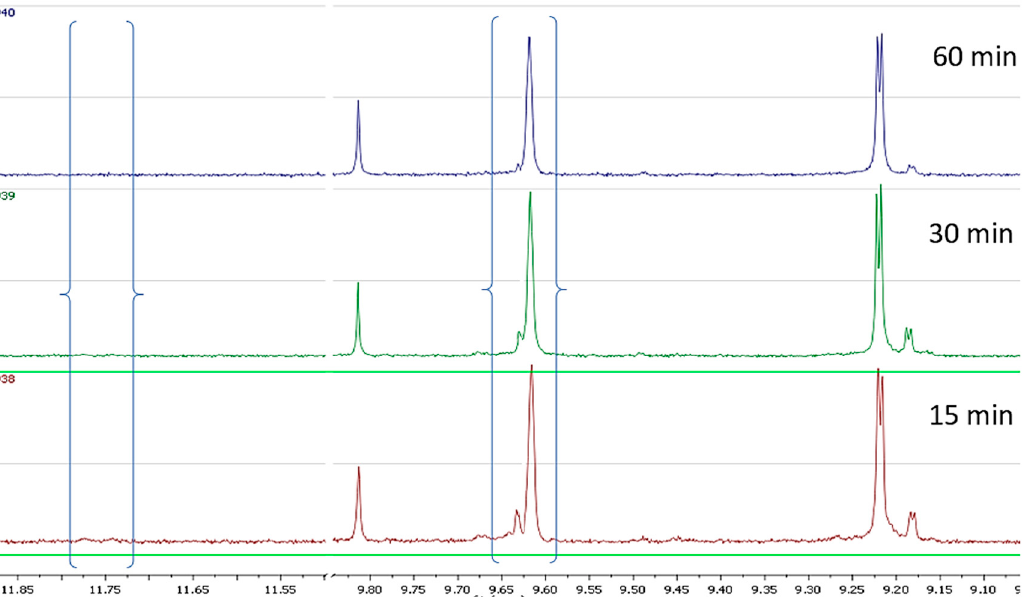
Figure 9. NMR profile of cv Kalamata at 28 °C, at three malaxation times, showing the characteristic peaks of the analyzed phenolic compounds.